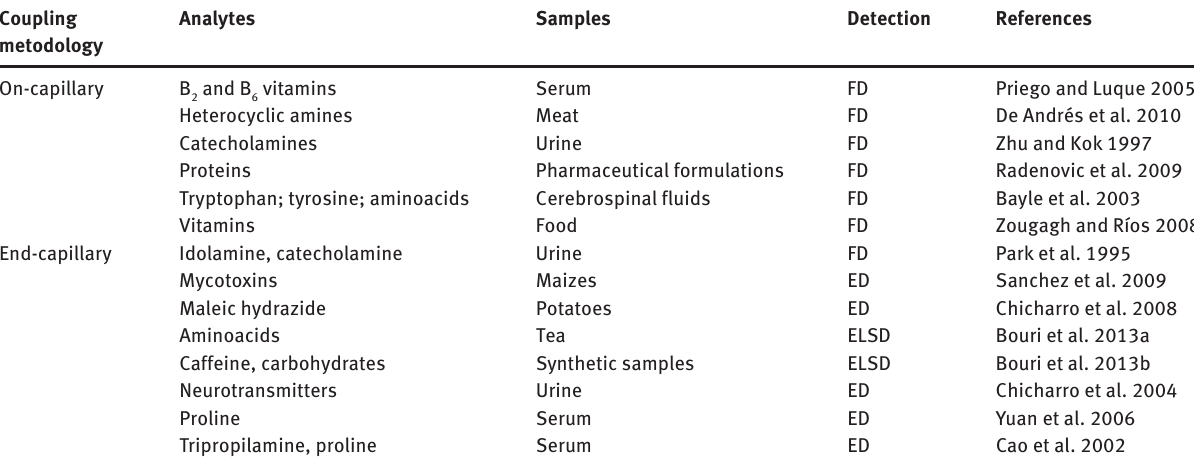
Table 2 On-capillary and end-capillary interfaced detector to commercial CE